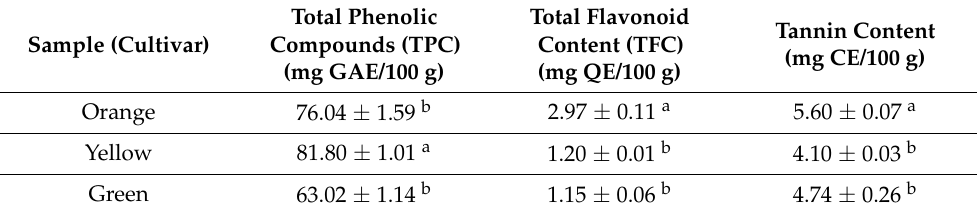
Table 3. Contents of total phenolic compounds, flavonoids, and tannins in the seeds of the three cultivars of prickly pear, namely orange, yellow, and green. Values in the same column followed by the same letter are not significantly different at p ≤